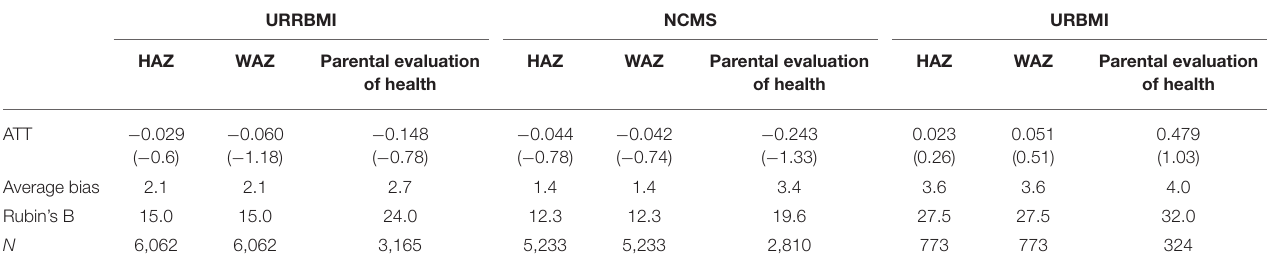
TABLE 8 | PSM estimates of URRBMI on children’s health. URRBMI NCMS URBMI HAZ WAZ Parental evaluation HAZ WAZ Parental evaluation HAZ WAZ Parental evaluation of health of health of health